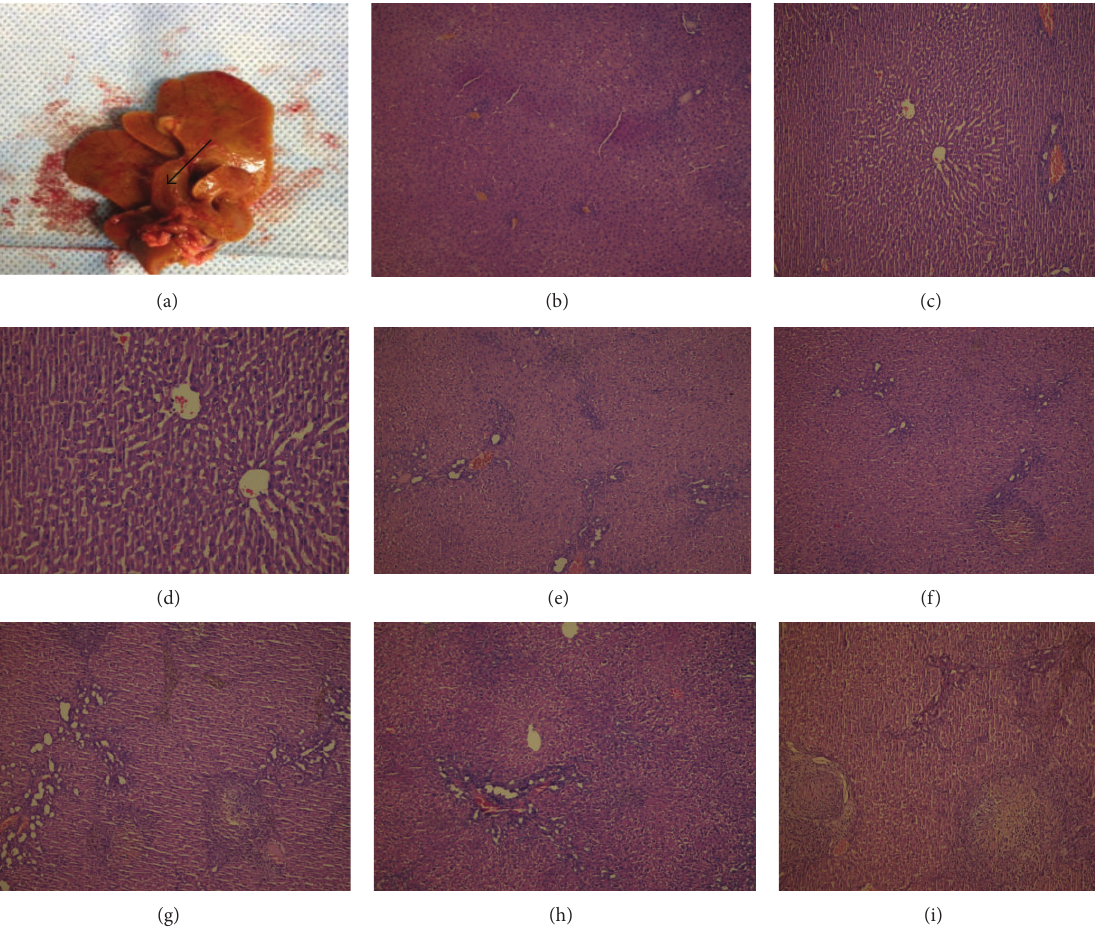
Figure 1: (a) Dilated common bile duct in rats (4 weeks after CBDL). (b) (Group A), (c) (Group B), and (d) (Group C): histological changes among groups (1 week after the CBDL). Minimal dilatation in the portal region, a few mononuclear cells, and ductal proliferation in portal regions are seen (H&E, × 200). (e) (Group B) and (f) (Group C): more intense inflammation and more ductile proliferation were observed (2 weeks after CBDL) (H&E, × 200). (g) (Group B): severe bridging fibrosis with enlargement of the portal region (H&E, × 200). (h) (Group C): no bridging fibrosis with enlargement of the portal region (H&E, × 200). (i) (Group